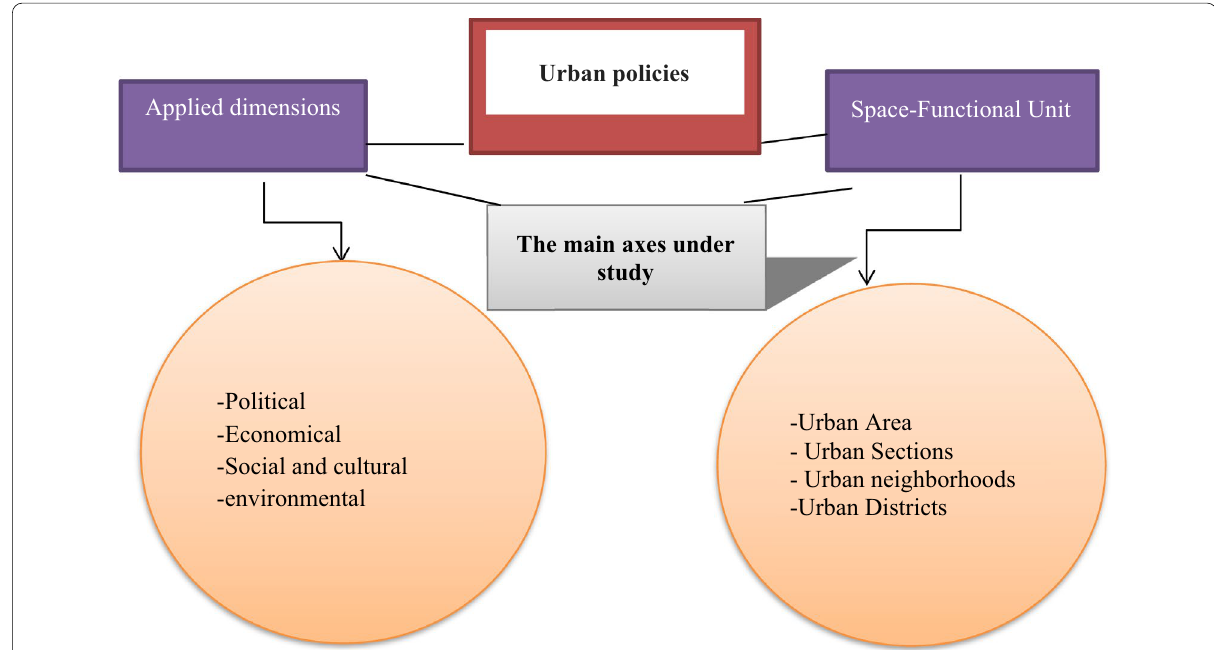
Fig. 1 Applied Model and Spatial and Functional Scale of Urban